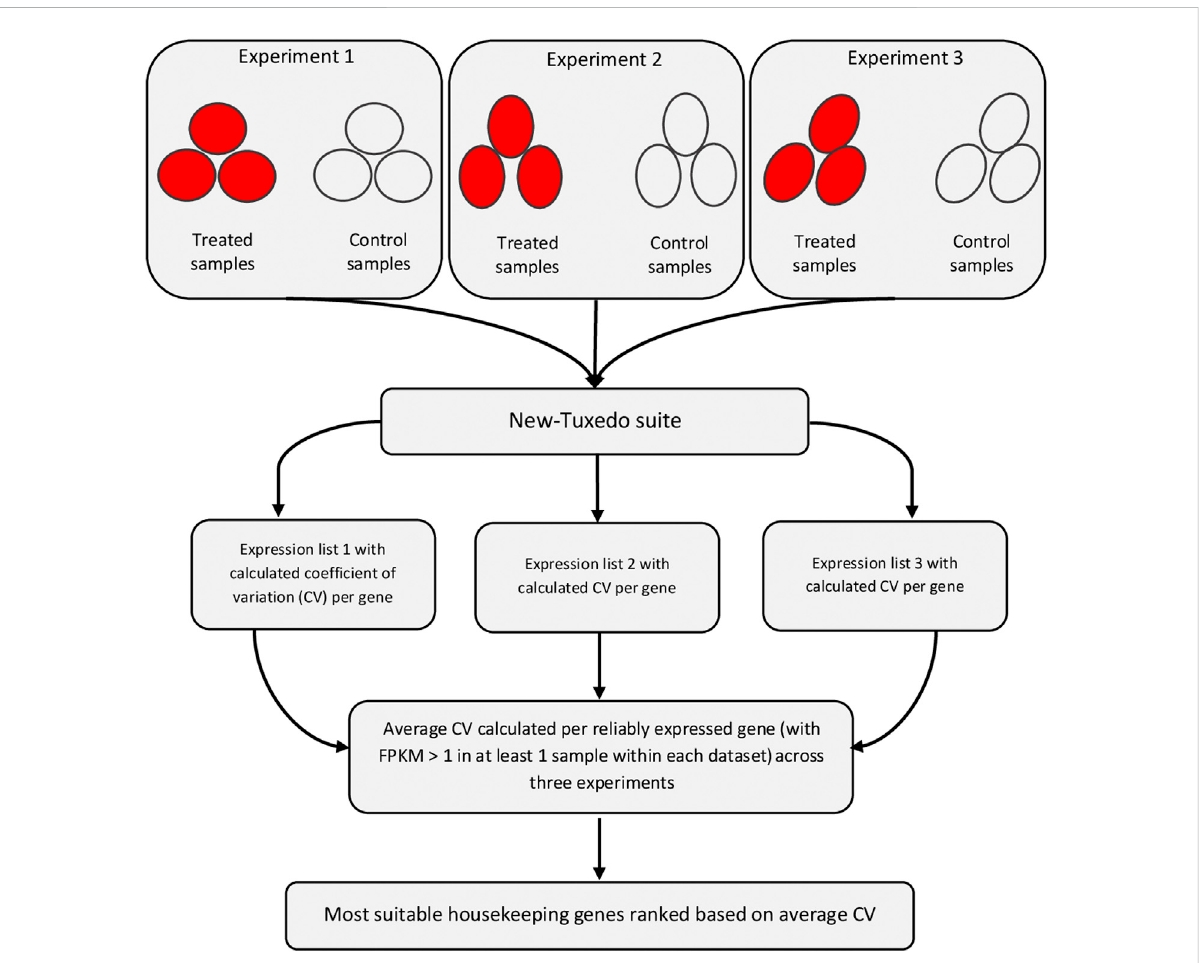
FIGURE 1 Flowchart of detection of the most suitable housekeeping genes for a speci fi c tissue. This work fl ow was repeated for all tissues separately. At least three datasets were analyzed per tissue. The comparisons within each experiment were performed between the treated and control groups, each with at least three replicates. All the used datasets are publicly available data generated using Illumina paired-end RNA-Sequencing method. Software programs within the New Tuxedo suite were hisat2 (for mapping of reads onto reference genome), Stringtie (for assembly and read counting), and Cuffdiff (for differentiall expression analysis). Expression stability was monitored per gene based on the coef fi cient of variation (CV), and ranking of most stably expressed genes were performed based on the average CV